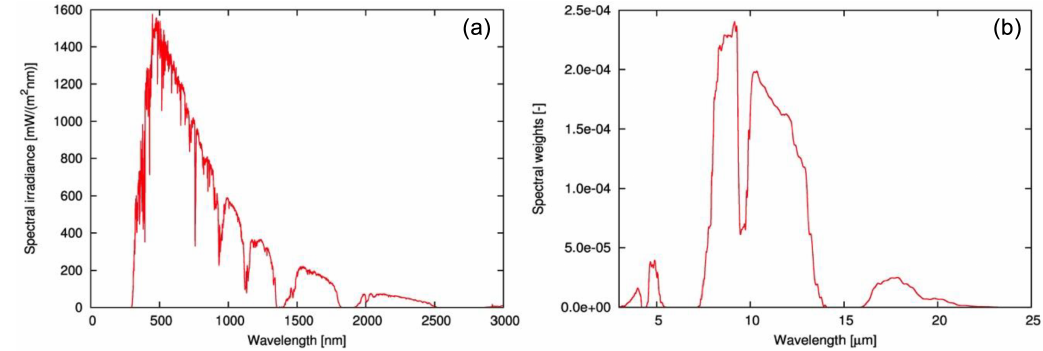
Figure 3. (a) The typical SW spectrum used for calculating average SW aerosol optical properties. (b) The spectral weights used for calculating average LW aerosol optical